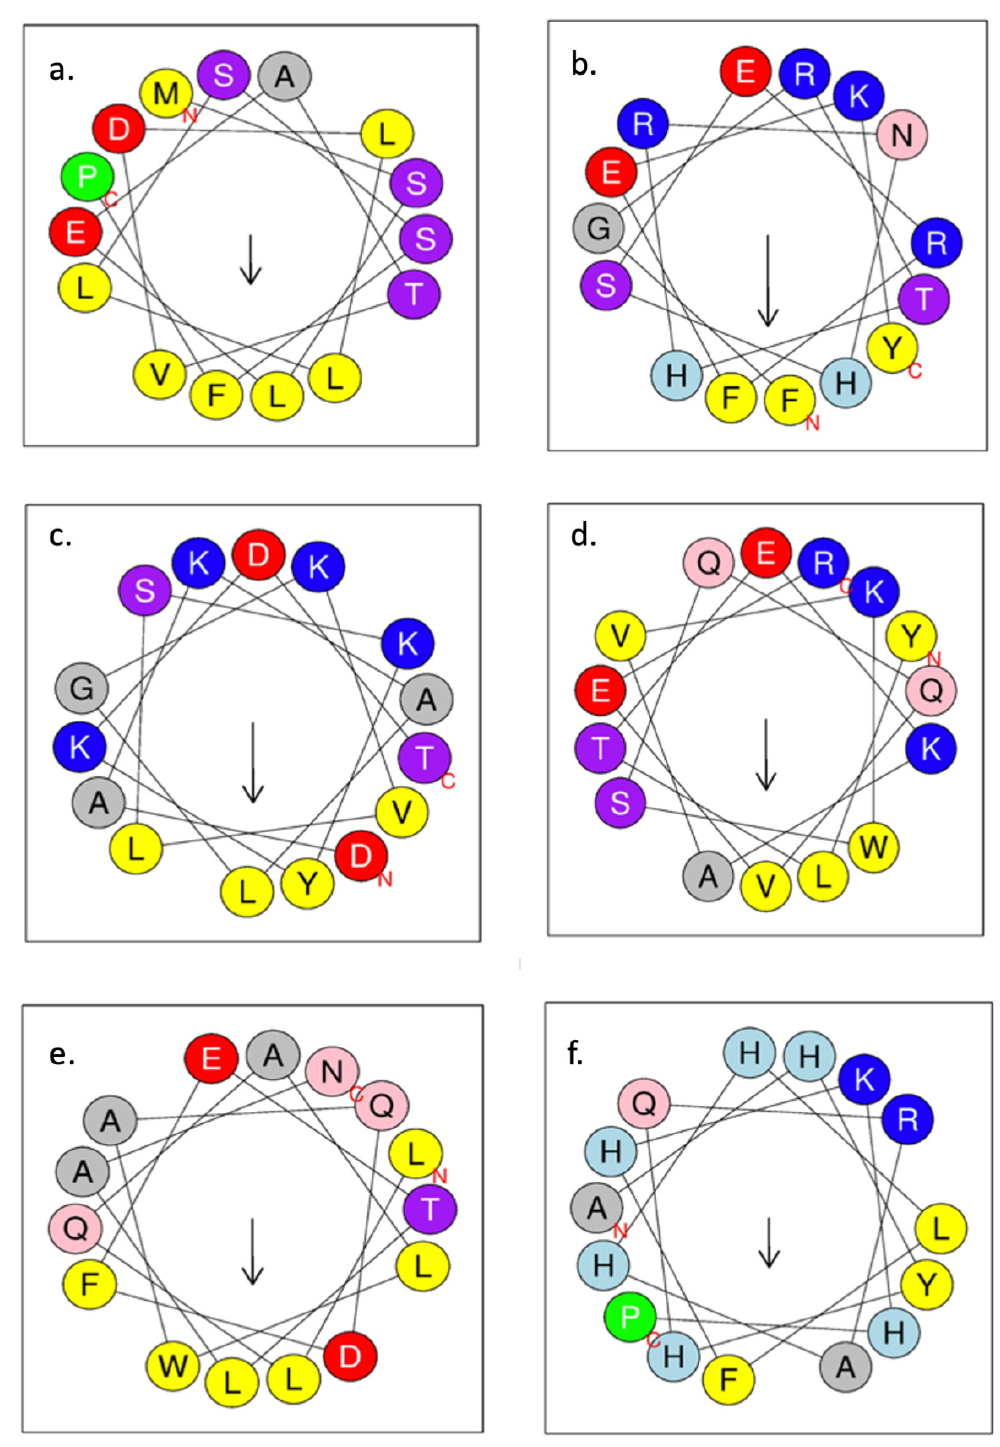
Figure 5. Helical wheel diagrams generated using the HELIQUEST server. Hydrophobic residues are shown in yellow, serine and threonine in purple, basic residues in dark blue, acidic residues in red, asparagine and glutamine in pink, alanine and glycine in grey, histidine in light blue and proline in green circles. Arrows represent direction and magnitude of the hydrophobic moment and residue marked with ‘N’ is the N-terminal end of the putative amphipathic helix with the residue marked ‘C’ being the C-terminal end. ( a ) Mt2055 putative amphipathic helix 1 (hydrophobic moment of 0.298). ( b ) Mt2055 putative amphipathic helix 2 (hydrophobic moment of 0.546). ( c ) Tmem41b putative amphipathic helix 1 (hydrophobic moment of 0.471). ( d ) Tmem41b putative amphipathic helix 2 (hydrophobic moment of 0.420). ( e ). YqjA putative amphipathic helix 1 (hydrophobic moment of 0.295). ( f ) YqjA putative amphipathic helix 2 (hydrophobic moment of